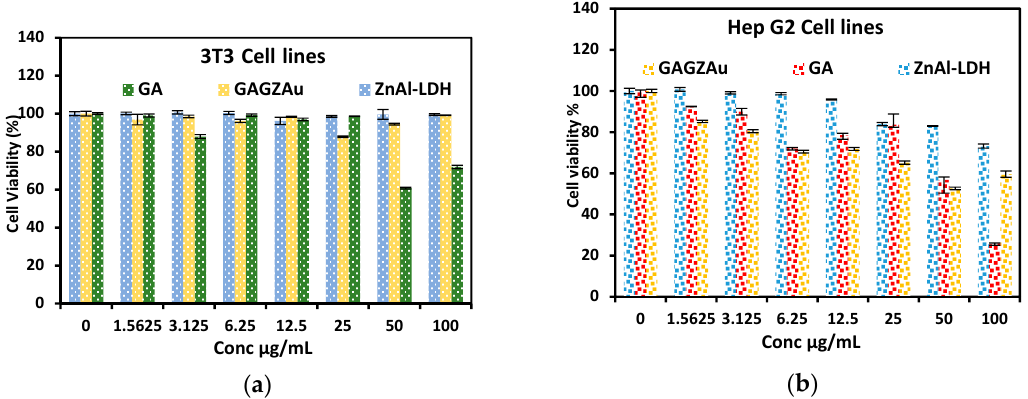
Figure 7. Cytotoxicity study of GAGZAu, LDH, and free drug at various concentrations exposed to ( a ) cancer cell lines (HepG2) and; ( b ) normal cell lines (3T3).